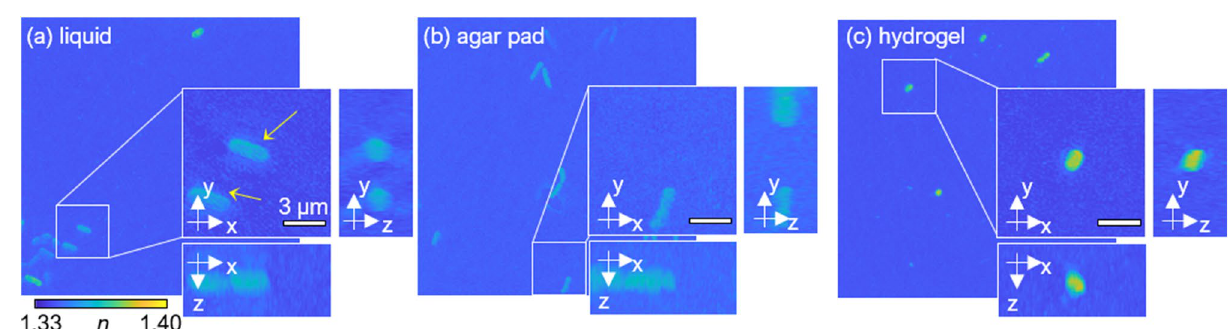
Figure 2. MIP visualization of 3D RI tomograms of K. pneumoniae in liquid ( a ), agar pad ( b ), and hydrogel ( c